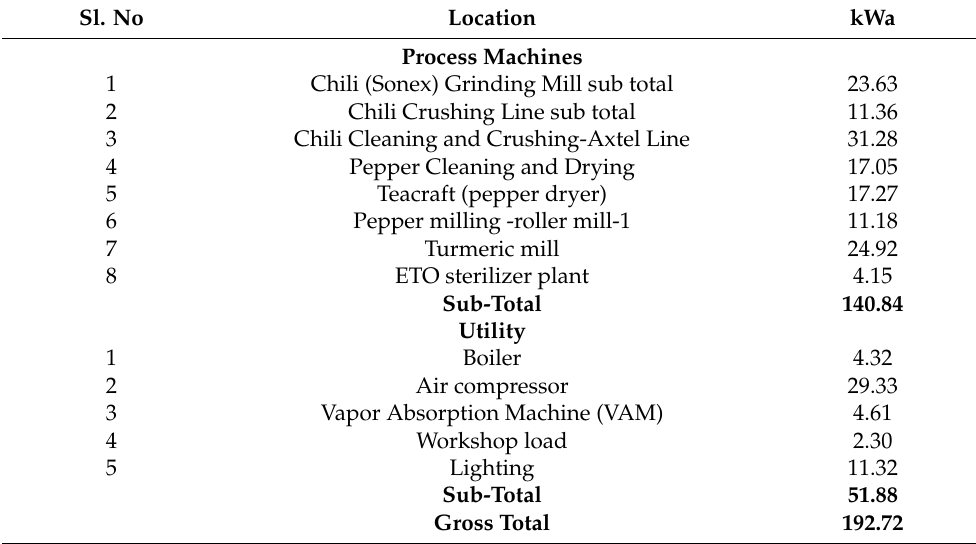
Table 4. Running loads in the plant as measured during the audit. Sl. No